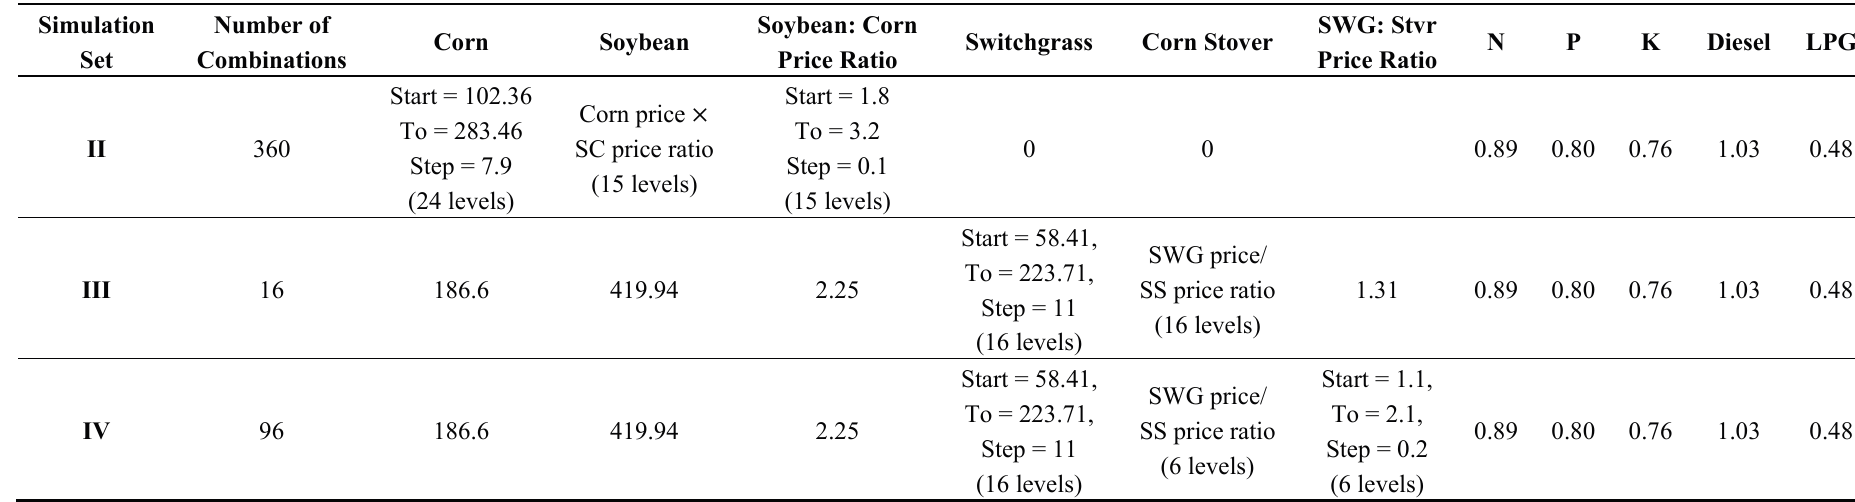
Table 3. Price levels of alternative scenarios (corn and soybean prices in $/metric ton, switchgrass and corn stover prices in $/metric